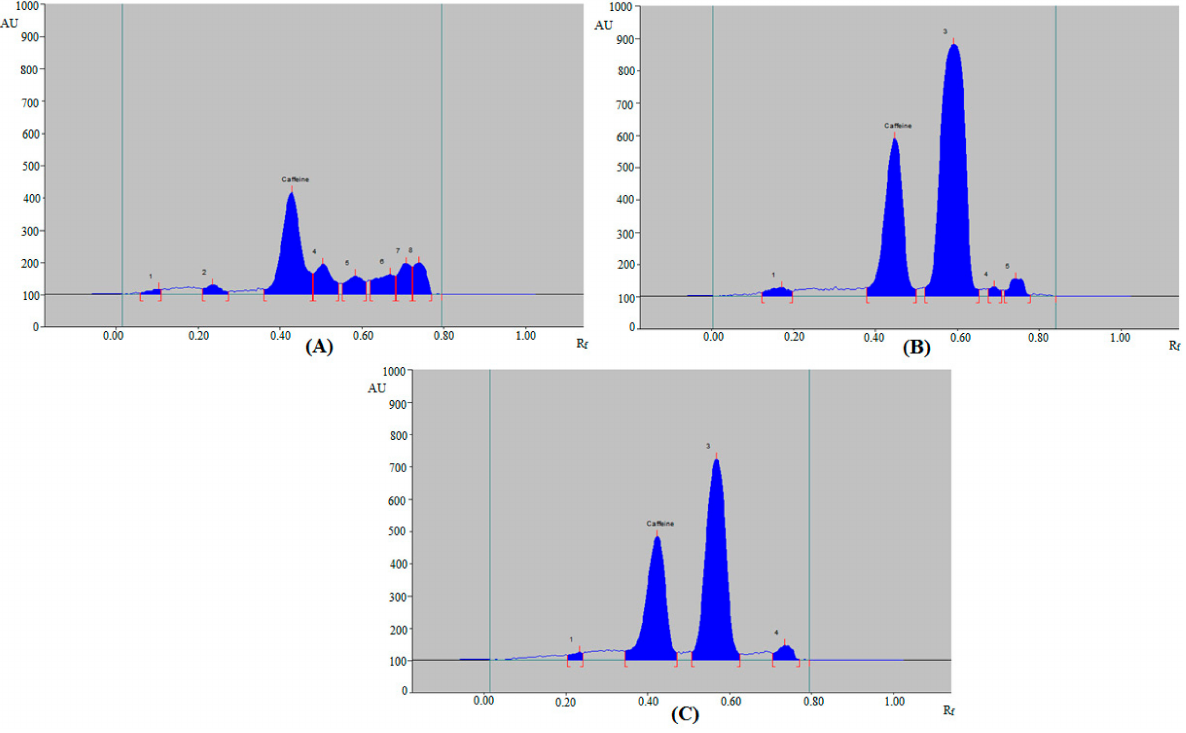
Figure 5. Representative chromatograms of caffeine in ( A ) marketed formulation F1, ( B ) marketed formulation F2, and ( C ) marketed formulation